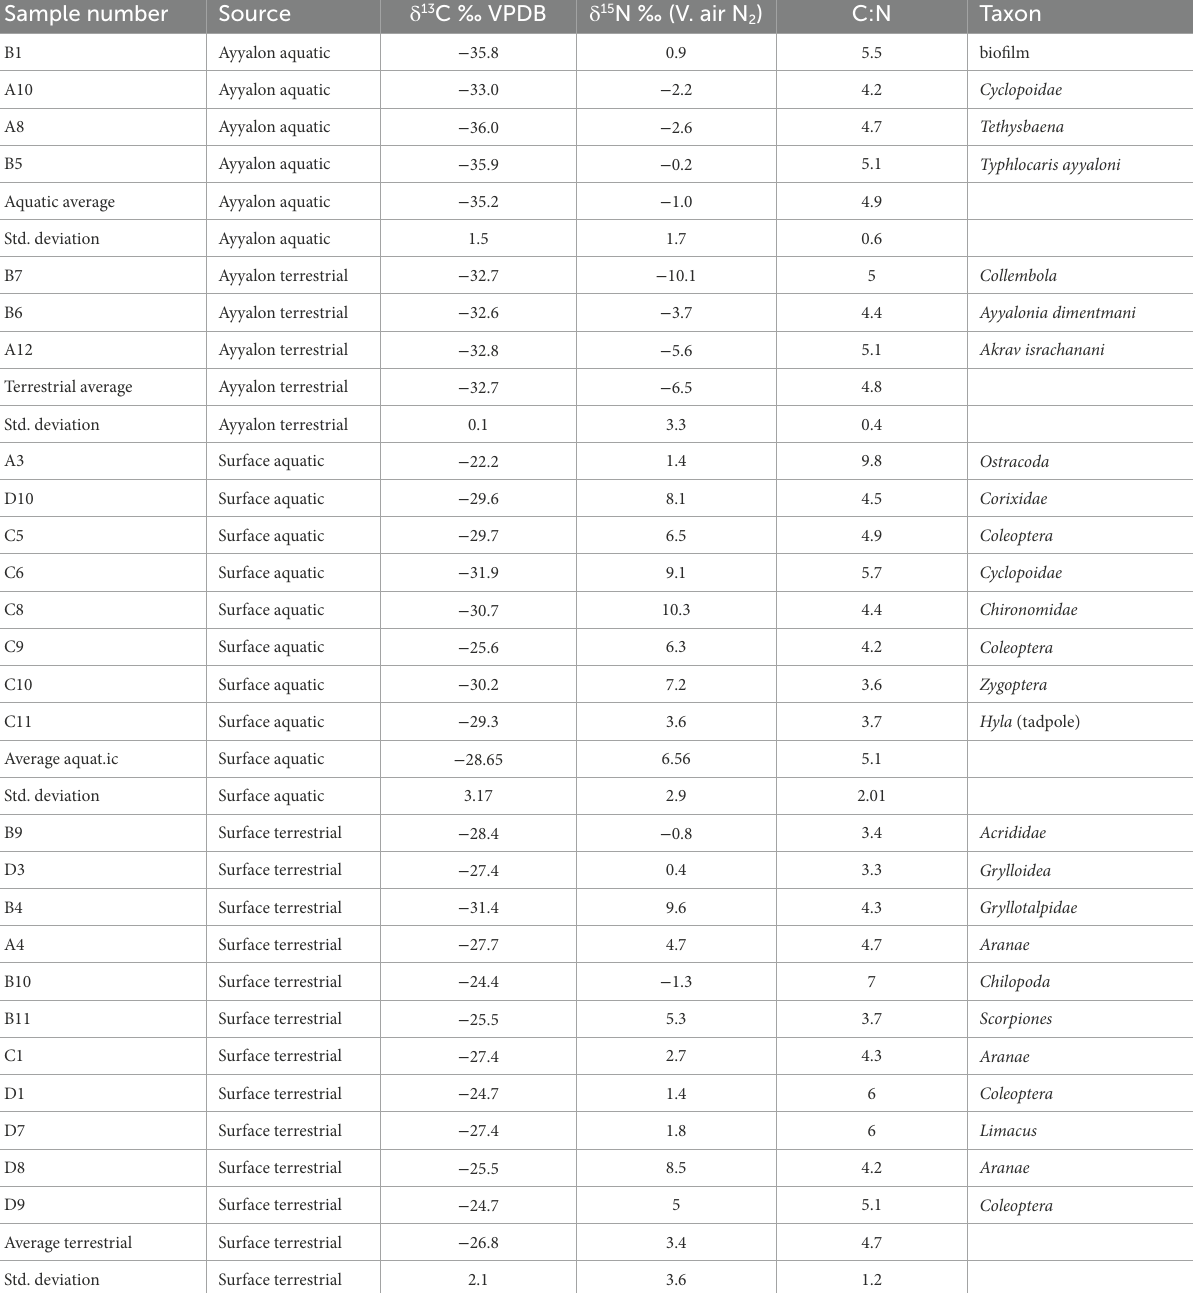
TABLE 4 Carbon and nitrogen stable isotope values of whole-body biogenic materials in Ayyalon Cave and associated surface near the